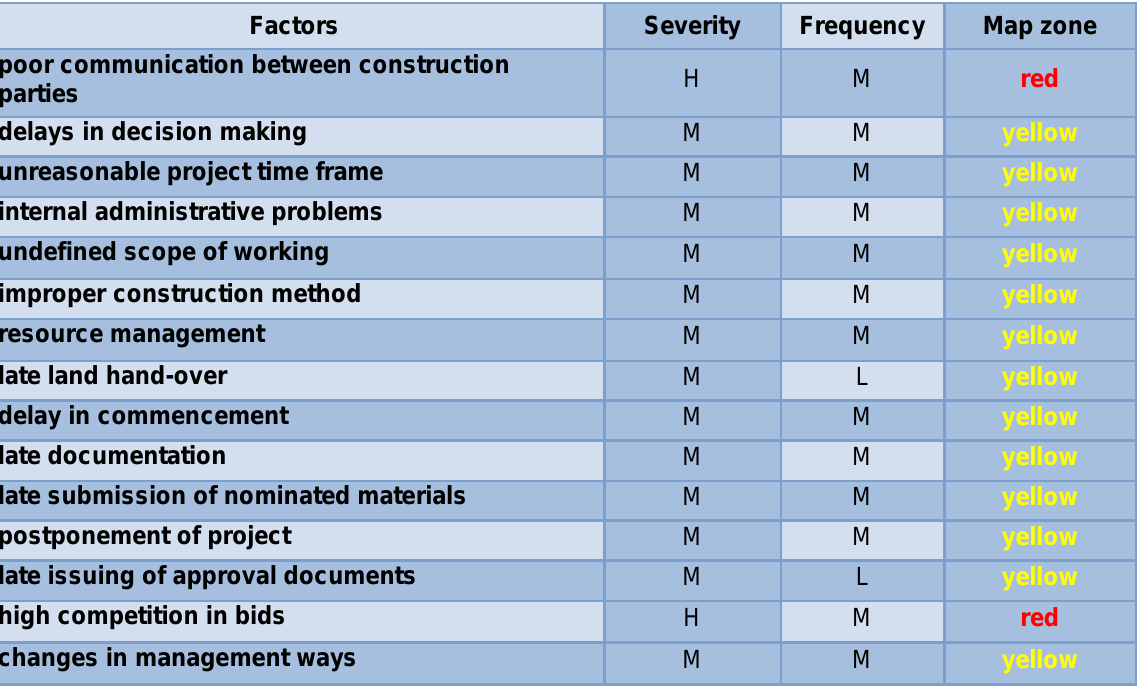
Table 3 Risk map for factors under managerial